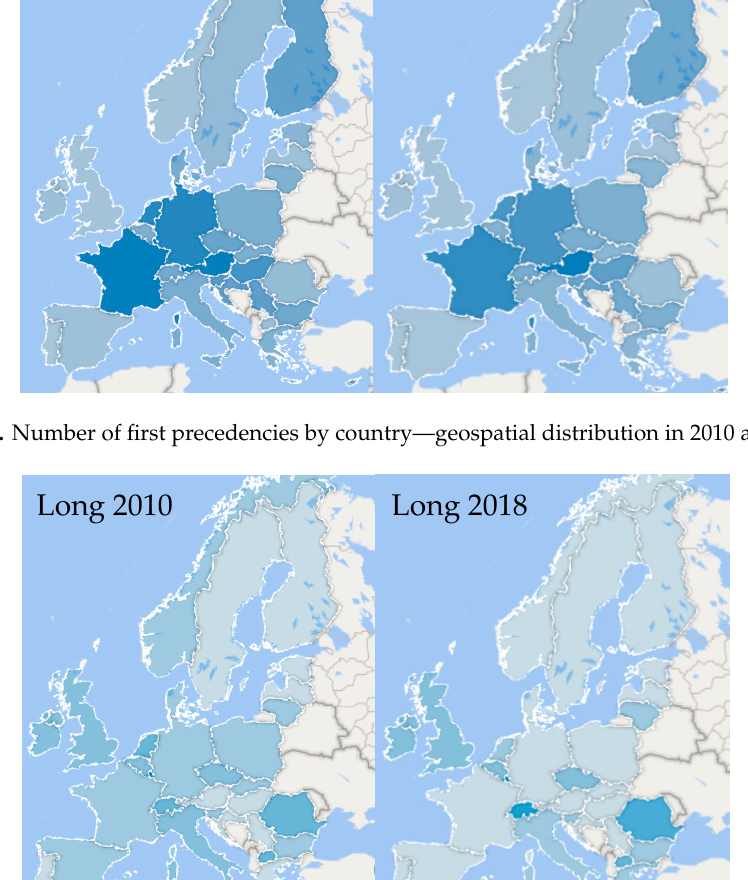
Figure 10. Number of long precedencies by country—geospatial distribution in 2010 and 2018.